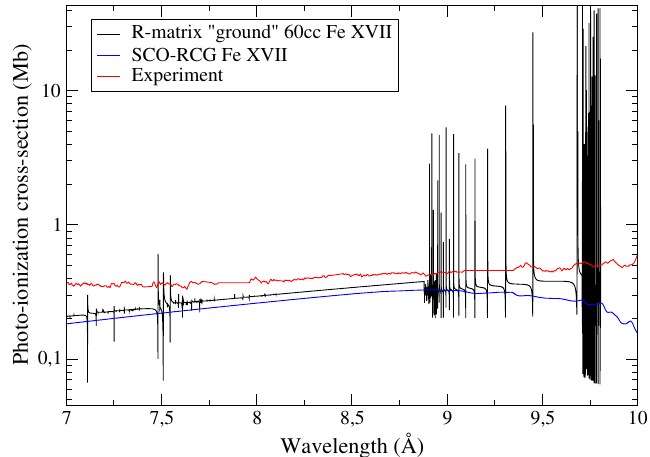
Figure 17. Comparison between the present SCO-RCG (distorted-wave) in blue and R-matrix [76] photo-ionization cross-sections (black curve) obtained from [44]. The experimental spectrum is also represented (red curve). The resonances in the black curve (PEC: photo-excitation of core) are the signature of transitions to a state coupled to the continuum (also known as Beutler-Fano autoionizing resonances